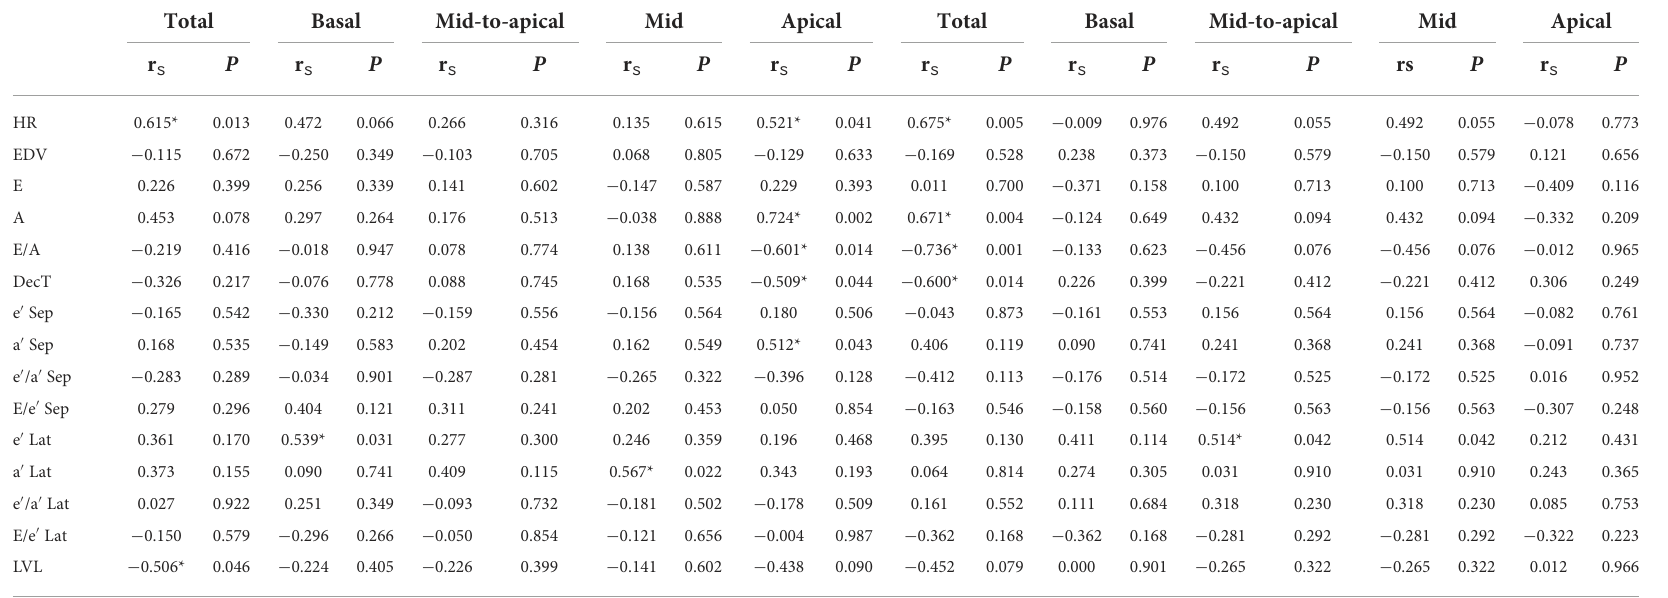
TABLE 3 Correlation between CMME indices and conventional echocardiographic measurements in